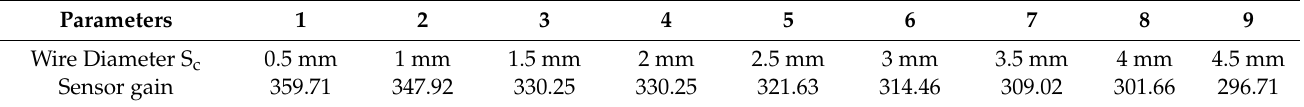
Table 3. Change the radius of the measurement conductor.